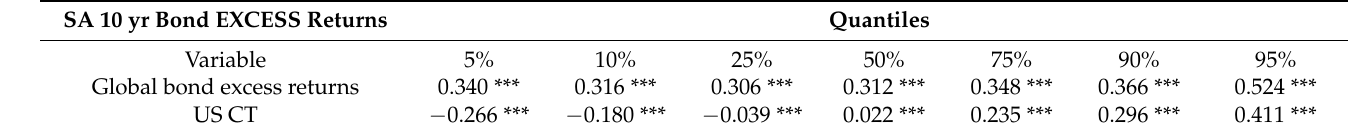
Table 3. Bond market results analysis (US carry trade).